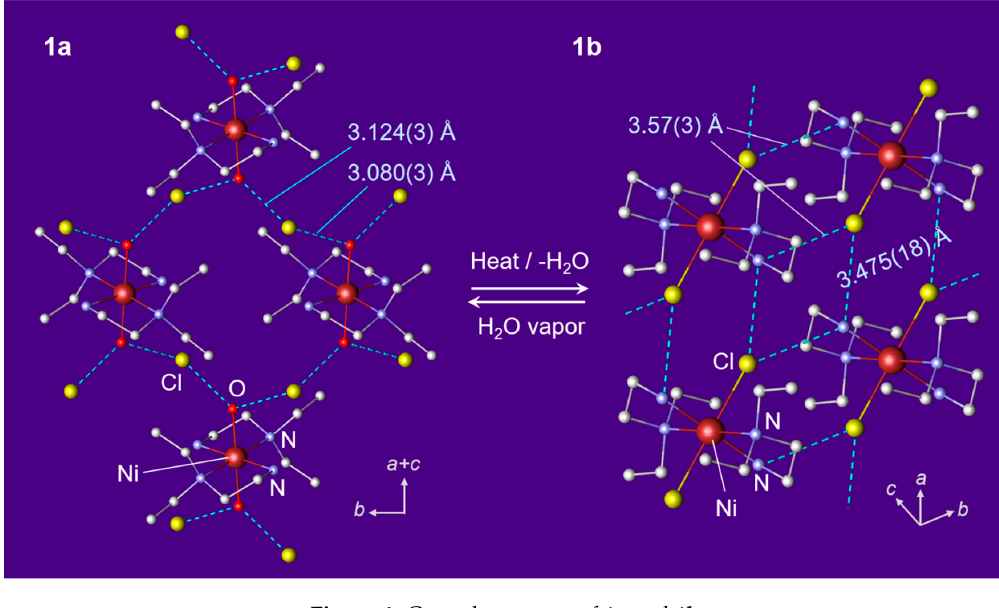
Figure 4. Crystal structure of 1a and 1b .